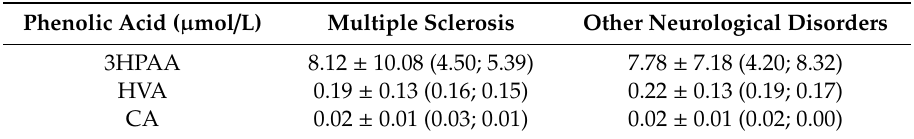
Figure 3. Concentrations of 3-hydroxyphenyl acetic acid ( A ), homovanillic acid ( B ) and ca ff eic acid ( C ) in cerebrospinal fluid (CSF) and matched plasma samples obtained form 28 studied patients. Results are expressed as mean ± SD and median; IQR (interquartile range). * versus corresponding value in plasma, p < 0.05. † versus blood-cerebrospinal fluid (CSF) concentrations of homovanillic acid and ca ff eic acid, p < 0.05. ‡ versus CSF concentration of ca ff eic acid, p < 0.05. Table 3. Concentrations of 3-hydroxyphenyl acetic acid (3HPAA), homovanillic acid (HVA) and ca ff eic acid (CA) in cerebrospinal fluid of patients subgroup with multiple sclerosis ( n = 15) and subgroup with other neurological disorders ( n = 13).